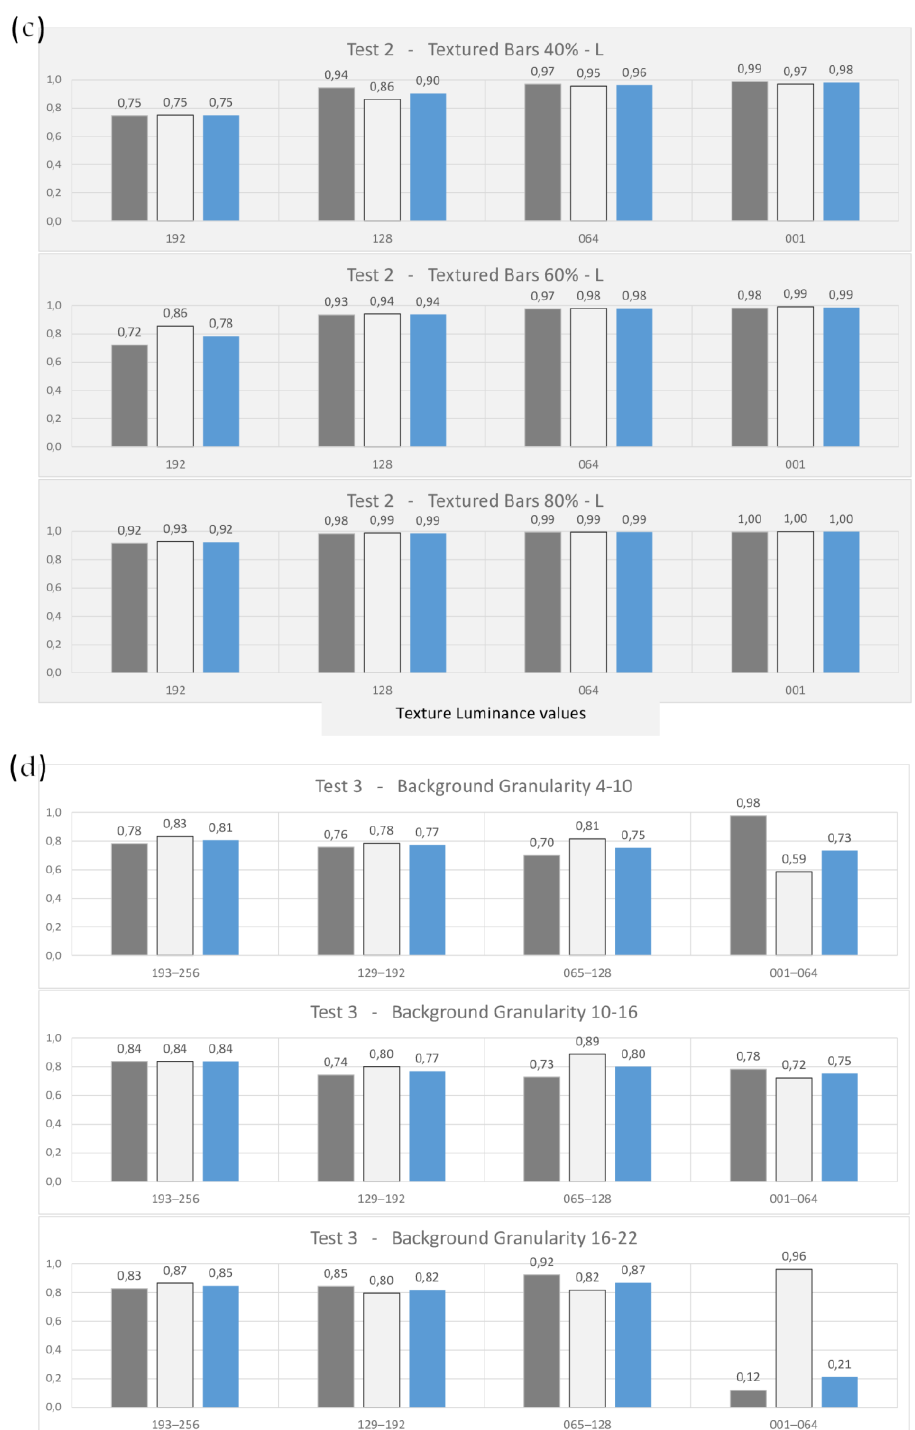
Figure 10. Classification performance analysis. In order to measure the classification capability of HMAX, we estimated three performances parameters according to each individual condition of the three different group of tests carried out. In order to apply the calculation, we assumed the Class A as the positive factor to be identified. For each condition, Precision (dark gray bars), Recall (light gray bars) and Score (blue bars) are calculated; the corresponding numerical values are shown above each bar. ( a ) The horizontal axis shows the six values corresponding to the luminance values tested for the Bar (upper graph), and for the Background (lower graph). The values indicate that with uniform Bars on a uniform Background, performance is high, and the three coefficients are close to unity. ( b ) and